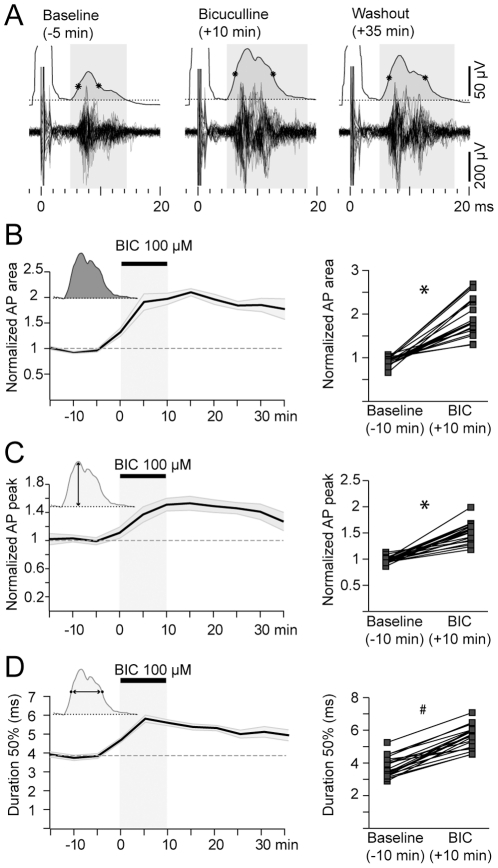
Intrastriatal bicuculline increases the amplitude and duration of striatal output.
A. Representative multiunitary response to cortical stimulation before, during and after delivering bicuculline into the striatum. The top trace corresponds to the rectified, smoothed and averaged action potential activity of 20 individual trials. Dotted line reflects 3 SD of multiunitary activity during 100 ms prior to stimulation onset (400 µA). Note the increase in the amplitude and duration of the response after bicuculline. Similar results were obtained for 300 µA cortical stimulation. B–D. Effect of bicuculline on the area (B), amplitude (C) and duration (D) of multiunitary action potential responses of 20 recording sites at the hot spot from 3 different experiments. * p<0.0001, Wilcoxon paired test. # p<0.0001 Student's paired t test.